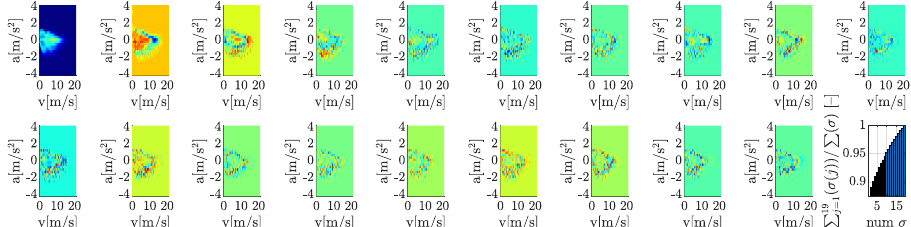
Figure 6. Representation of the 19 modes obtained by SVD of the SAPDs shown in Figure 5 and amount of the variance or energy in the measured SAPDs captured depending on the number of modes